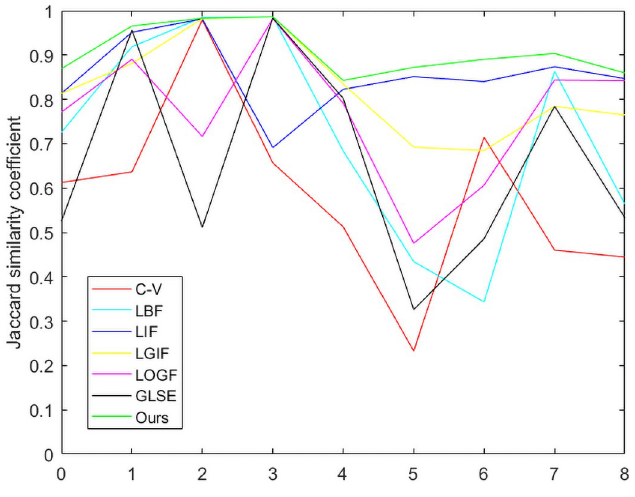
Fig 12. Comparison of various models in terms the JSC .